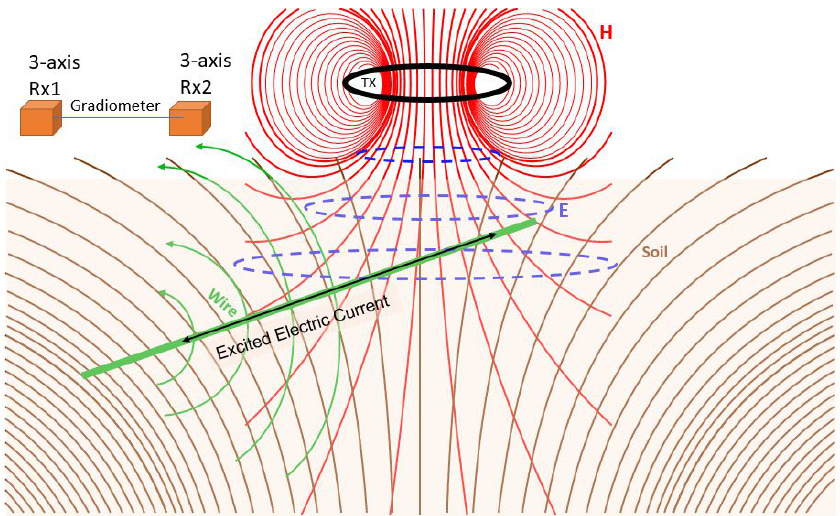
Figure 7. Theoretical geometry of a buried